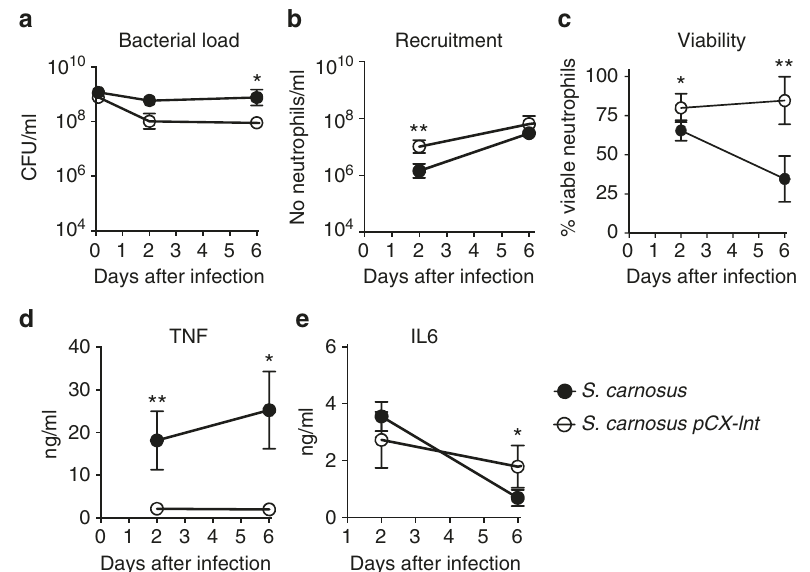
Fig. 7 Mice and tissue cage infection model. Tissue cages were implanted in C57BL/6 mice and infected percutanously with around 10 9 S. carnosus ( fi lled) and S. carnosus lnt (open). ( a ) Bacteria and ( b ) neutrophils were counted, ( c ) neutrophil viability was determined, and ( d ) TNF and ( e ) IL-6 concentrations were measured in tissue cage fl uid (TCF) during 6 days. * P ≤ 0.05 and ** P ≤ 0.01, analyzed using Mann – Whitney test. Data show mean ± s.d. of 5 – 6 mice in each group from two independent